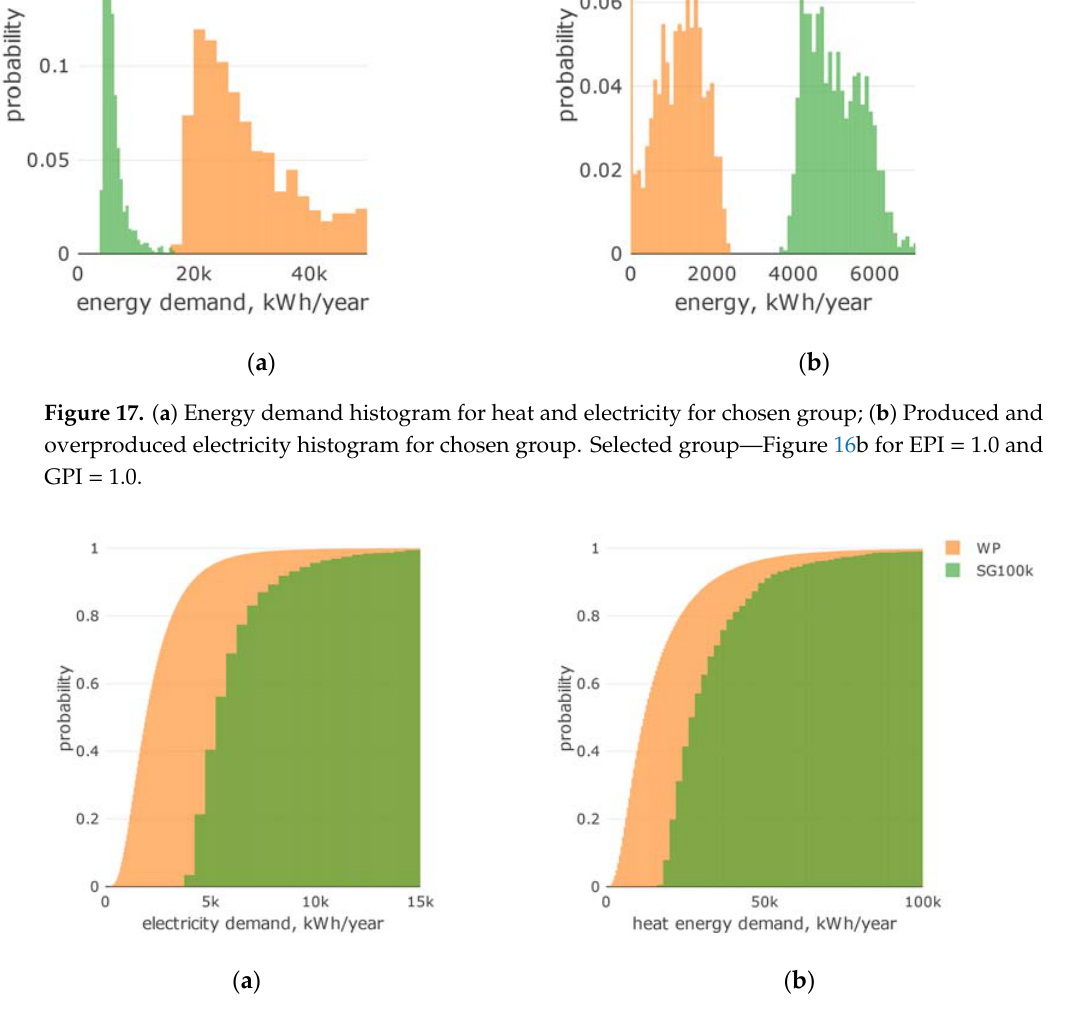
Figure 18. ( a ) Electricity demand cumulative histogram for whole population WP and selected group (SG100k); ( b ) Heat energy demand cumulative histogram for whole population WP and selected group